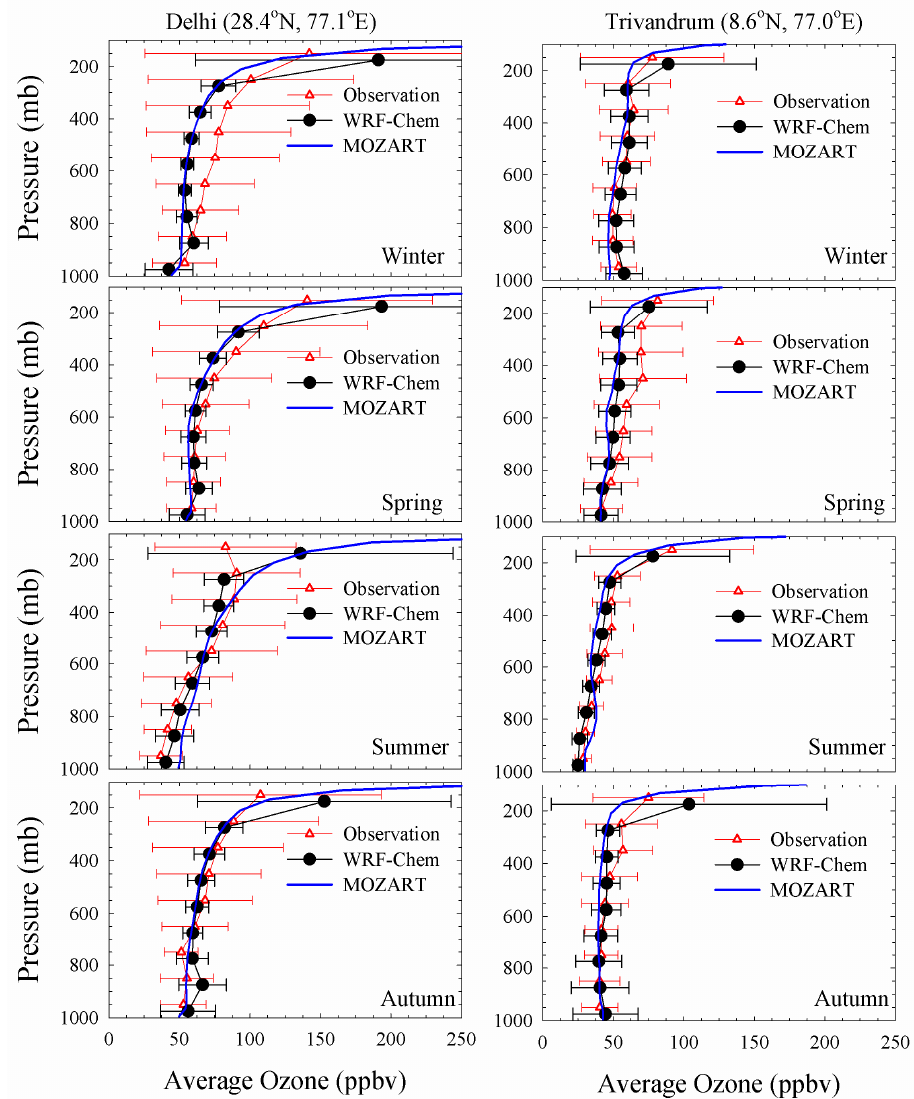
Fig. 6. Comparison of the vertical profiles of ozone mixing ratios observed by ozonesondes and simulated by WRF-Chem in Delhi and Trivandrum. The observed profiles shown here are averages of all the ozonesonde measurements available during 2000–2009. Seasonally averaged MOZART ozone profiles for both sites are also shown to demonstrate the influence of boundary conditions.